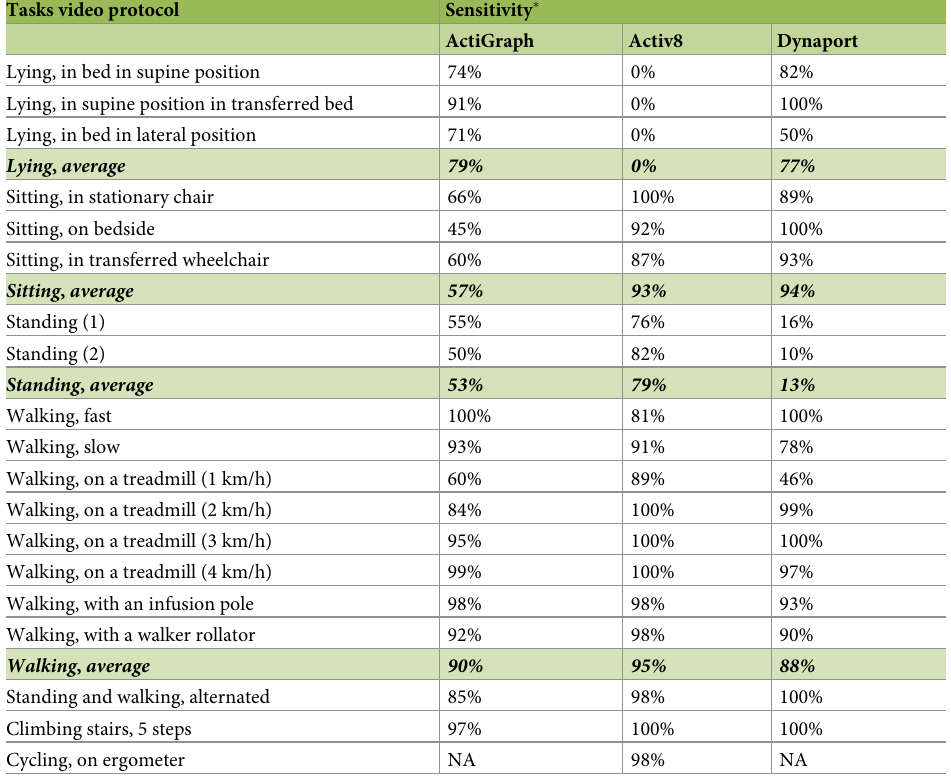
Table 3. Sensitivity per accelerometer, per task.